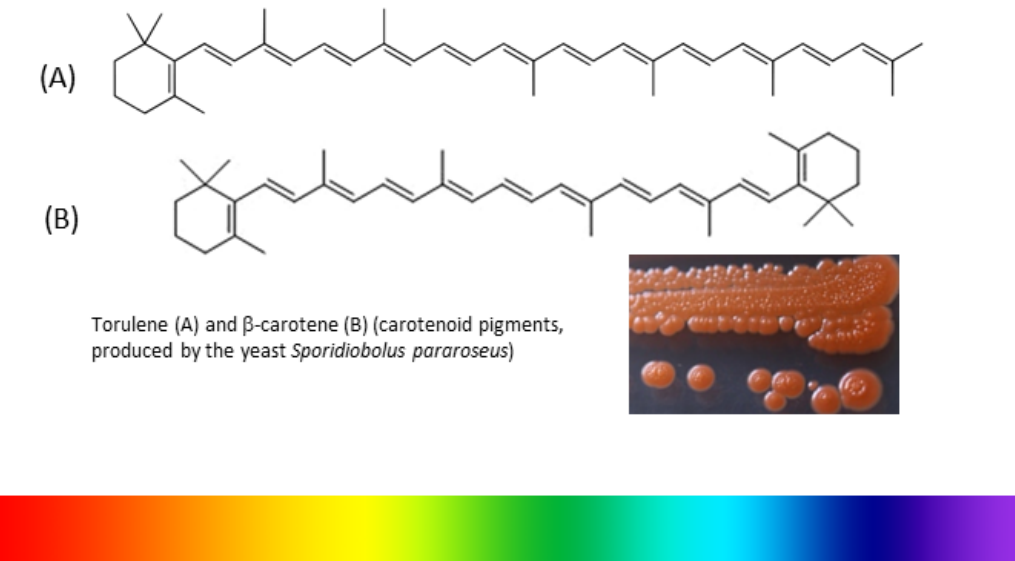
Figure 3. Chemical structures of fungal pigments with potential coloring properties that could be used in textile dyeing.